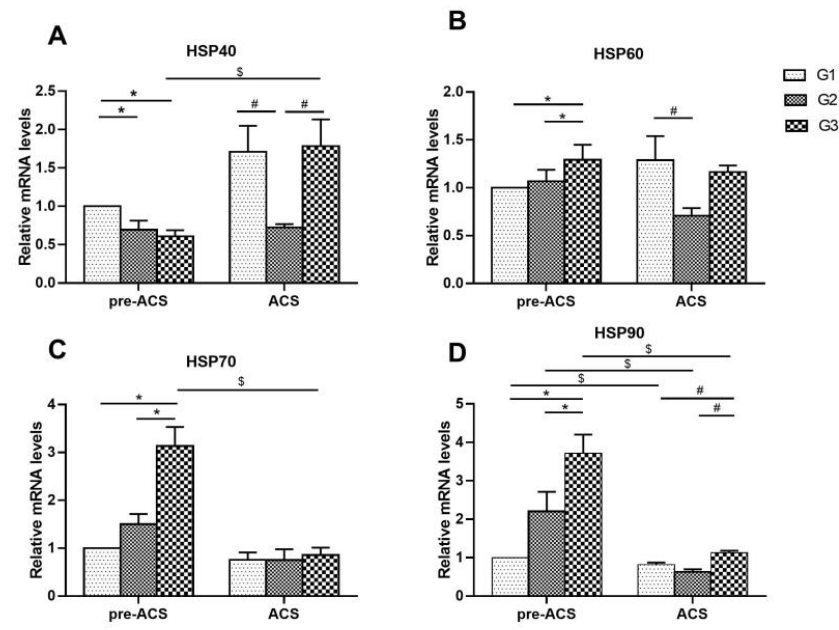
Figure 6. The mRNA levels of heat shock proteins HSP40 ( A ), HSP60 ( B ), HSP70 ( C ), and HSP90 ( D ) in ilea of broilers before and after ACS. Data were presented as mean ± SD ( n = 6). Different labels represent significant differences ( p < 0.05). pre-ACS (*), ACS (#) and before and after ACS ($). G1, cold stimulation for 0 h; G2, cold stimulation for 3 h; G3, cold stimulation for 6 h.